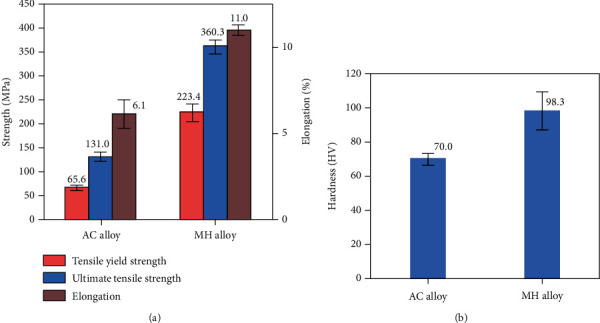
The mechanical properties [7, 30] (a) and microhardness (b) of the AC and MH alloys.